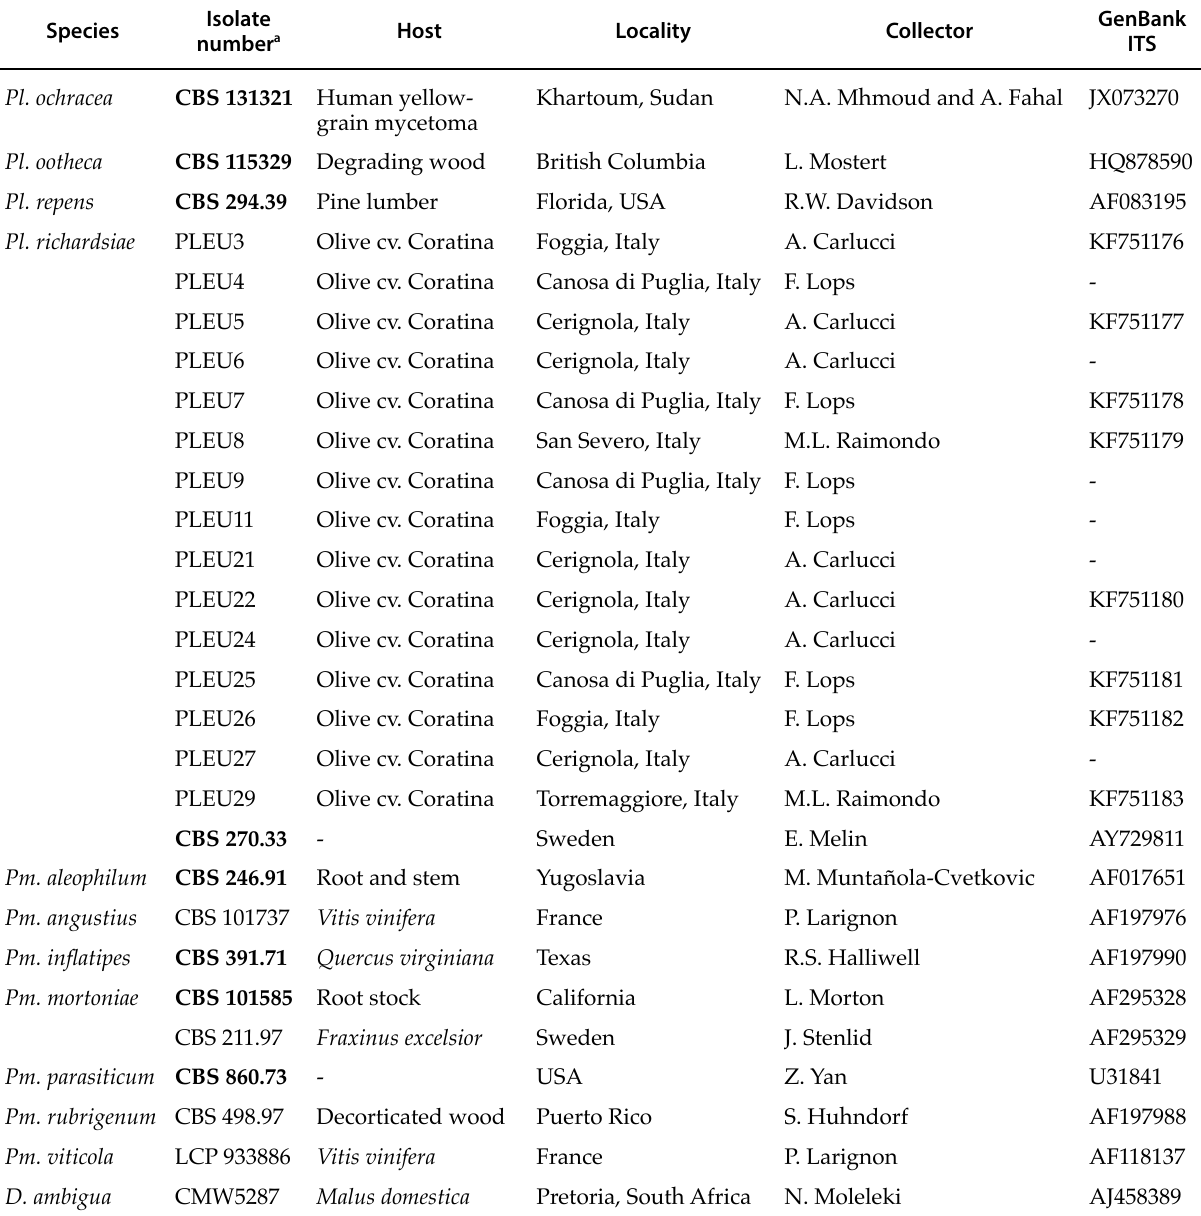
Table 2. Fungal isolates used in the phylogenetic study